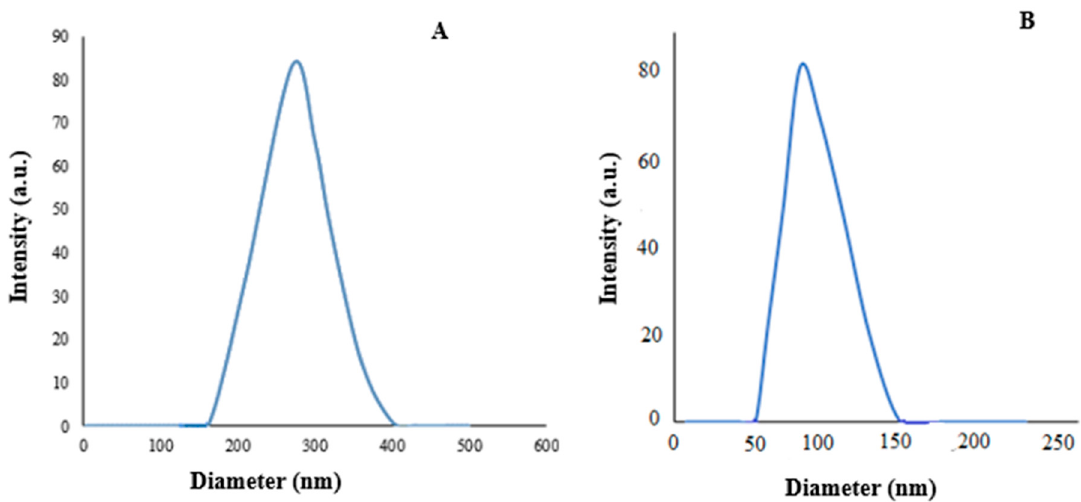
Figure 2. DLS measurement of particle size distribution of AL–acetamiprid ( A ) and PEG–acetamiprid ( B )